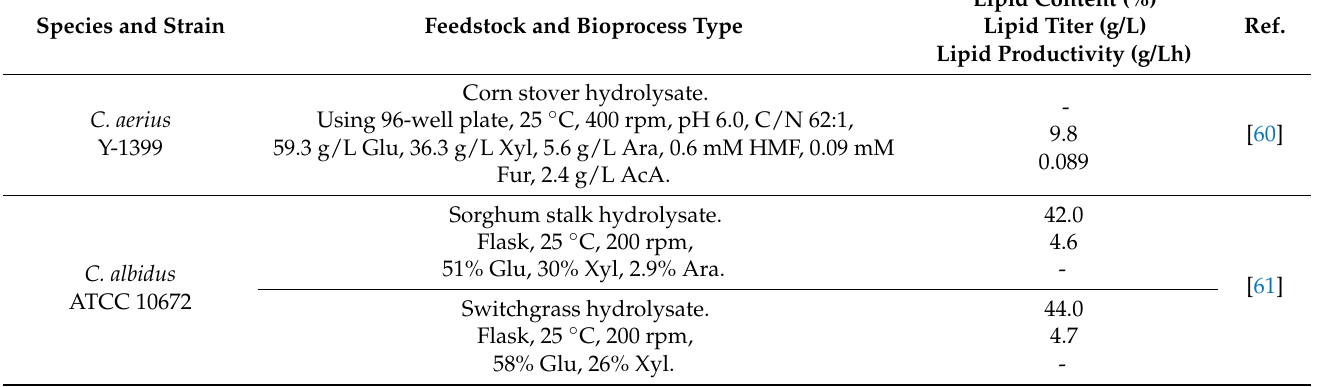
Lipid Content (%) Lipid Titer (g/L) Lipid Productivity (g/Lh)